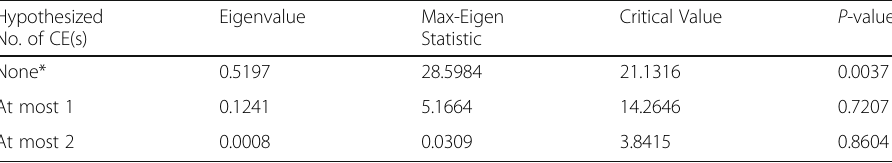
Table 3 Johansen cointegration test Hypothesized No. of CE(s)